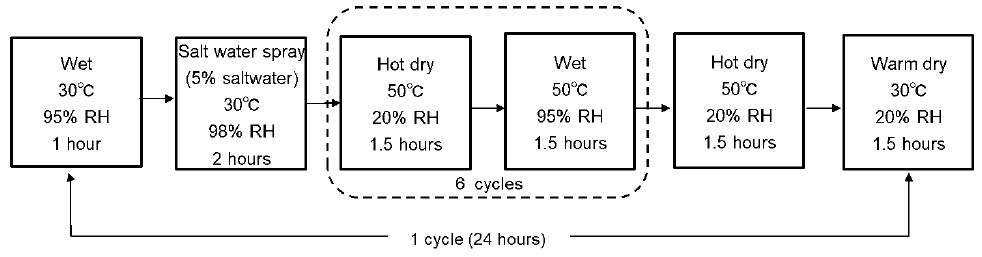
Figure 4. The procedure of PWRI.